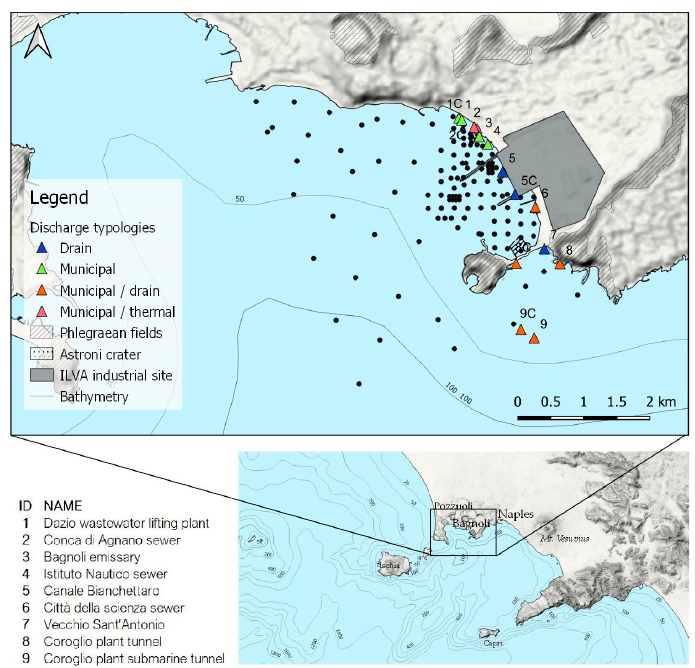
Figure 3. Location and typology of sewage discharges located along the Bagnoli coastline. The capital letter “C” indicates the discharges which control the nearest discharge point (i.e., 9C is the control point of Discharge Point 9).